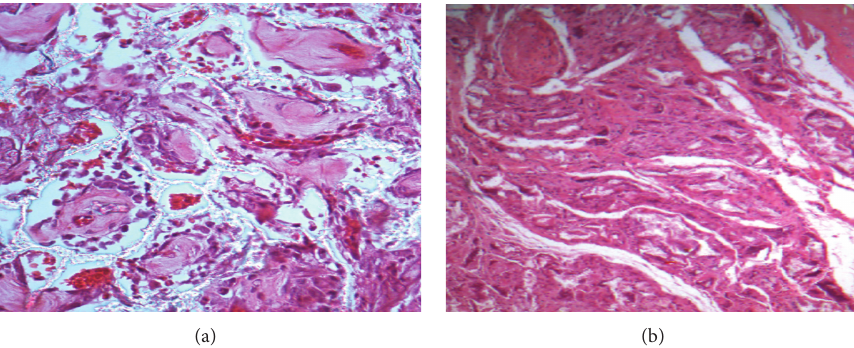
Figure 4: In the first two weeks after the end of the extension, in group A, osteoid based on fibrous callus can be seen in most of the materials